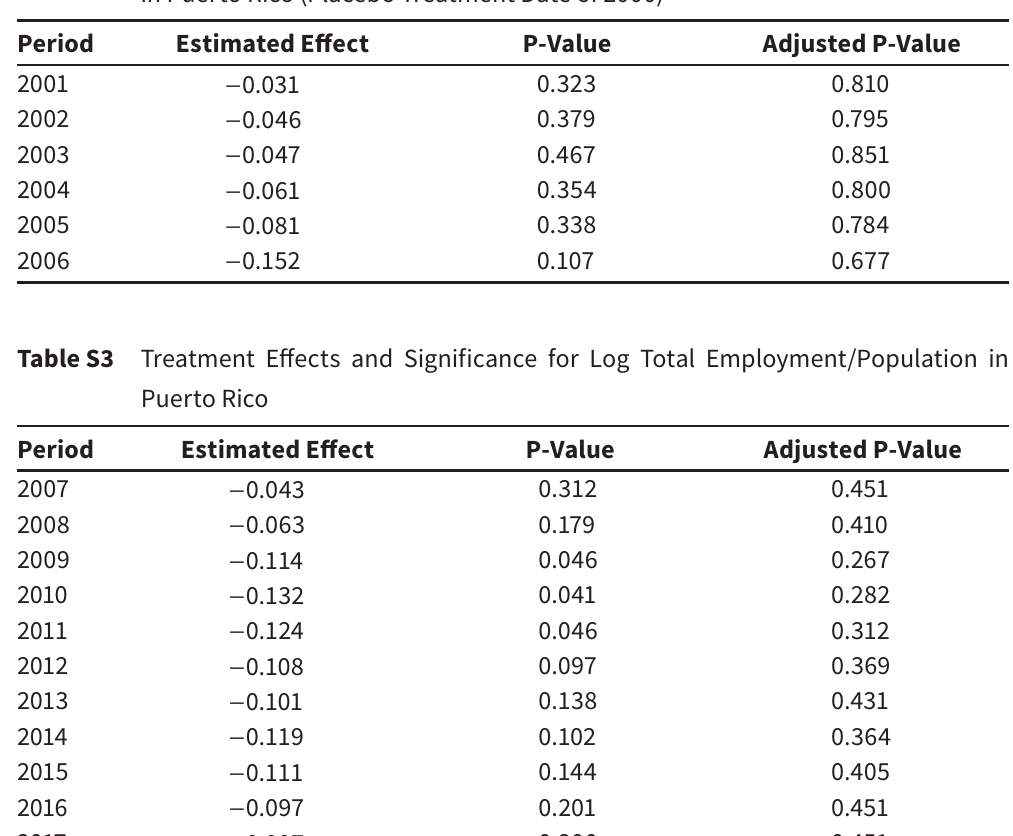
Treatment Effects and Significance for Log Teen Employment/Population Ratio in Puerto Rico (Placebo Treatment Date of 2000)